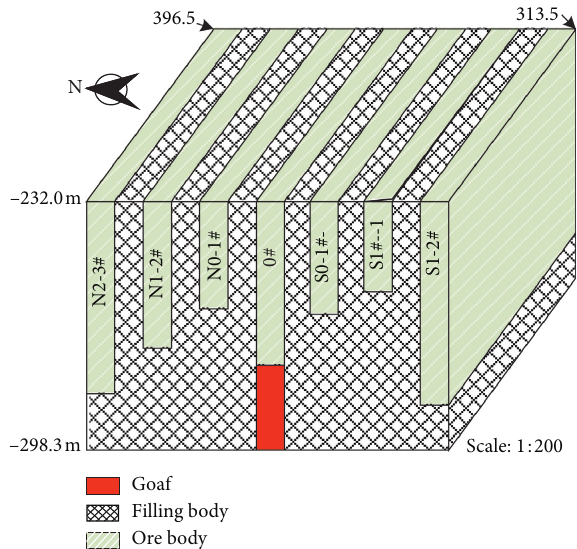
Figure 1: Status of instability in the collapse